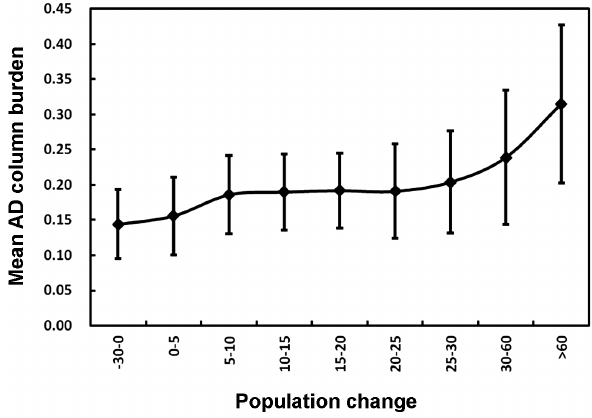
Figure 10. Mean anthropogenic dust (AD) column burden (gm − 2 ) changes as a function of population change (personskm − 2 ).